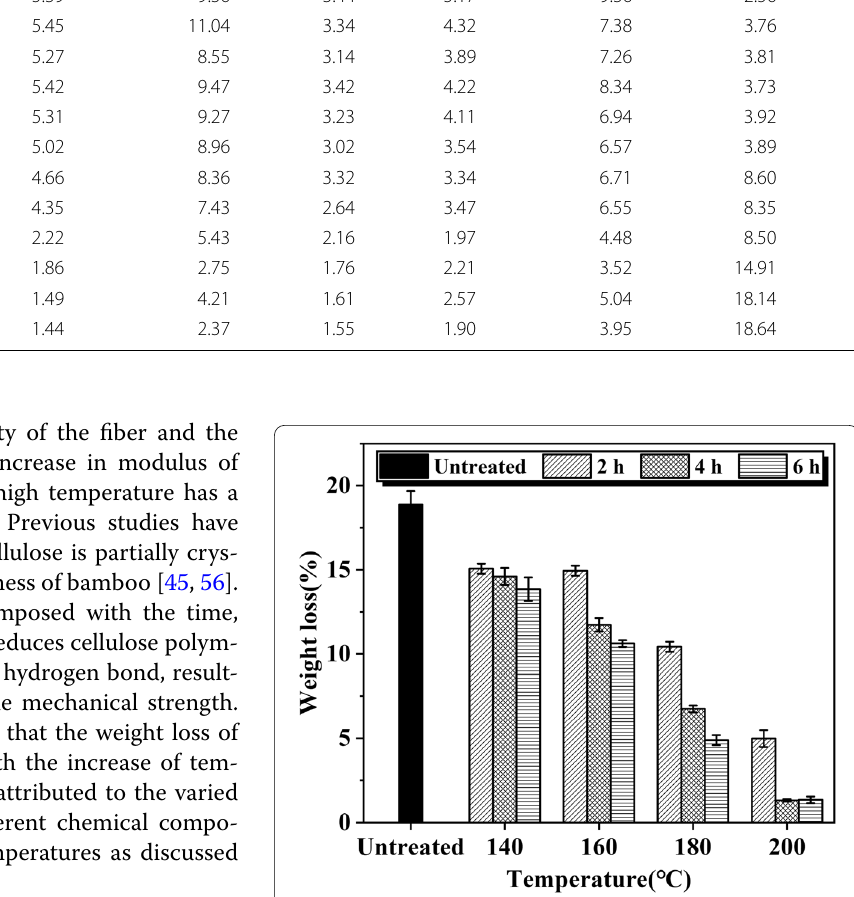
Fig. 9 The weight loss of samples after incubation with brown-rot fungi for 45